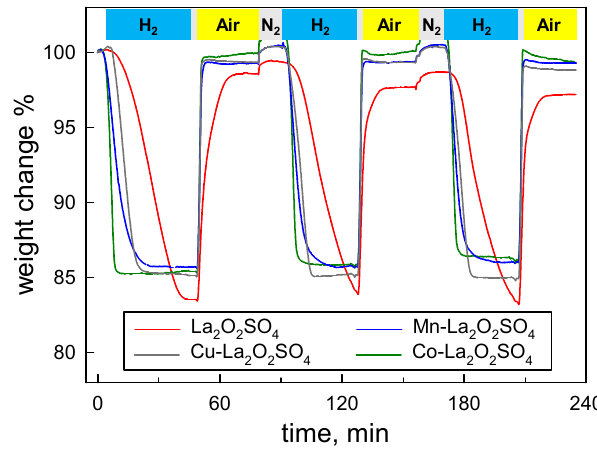
Figure 5. Weight changes during chemical looping reactions under cycled feed stream of 5% CH 4 /N 2 and air at 800 °C over La 2 O 2 SO 4 and metal (Cu, Mn, Co) promoted La 2 O 2 SO 4 .